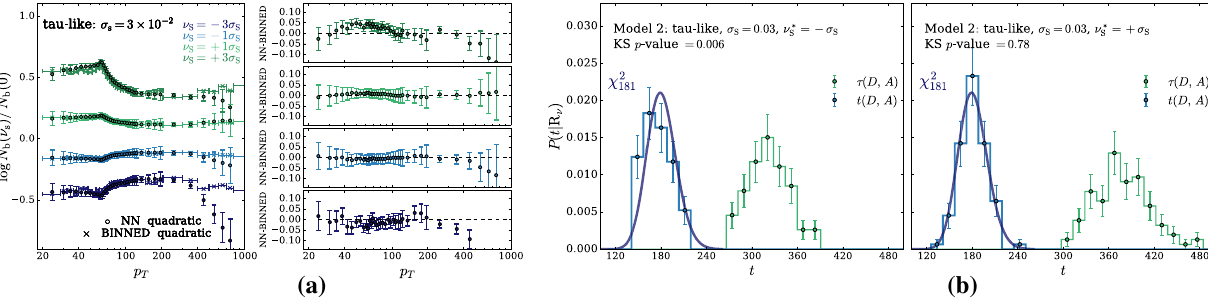
Fig. 21 Leftside:thereconstructeddistributionlog-ratio(dots)fordif- ferent values of ν s , compared with the quadratic binned approximation. Right side: the empirical distribution of τ (in green) and of t (in blue) computed by 100 toy experiments performed for Model 2 in the R ν